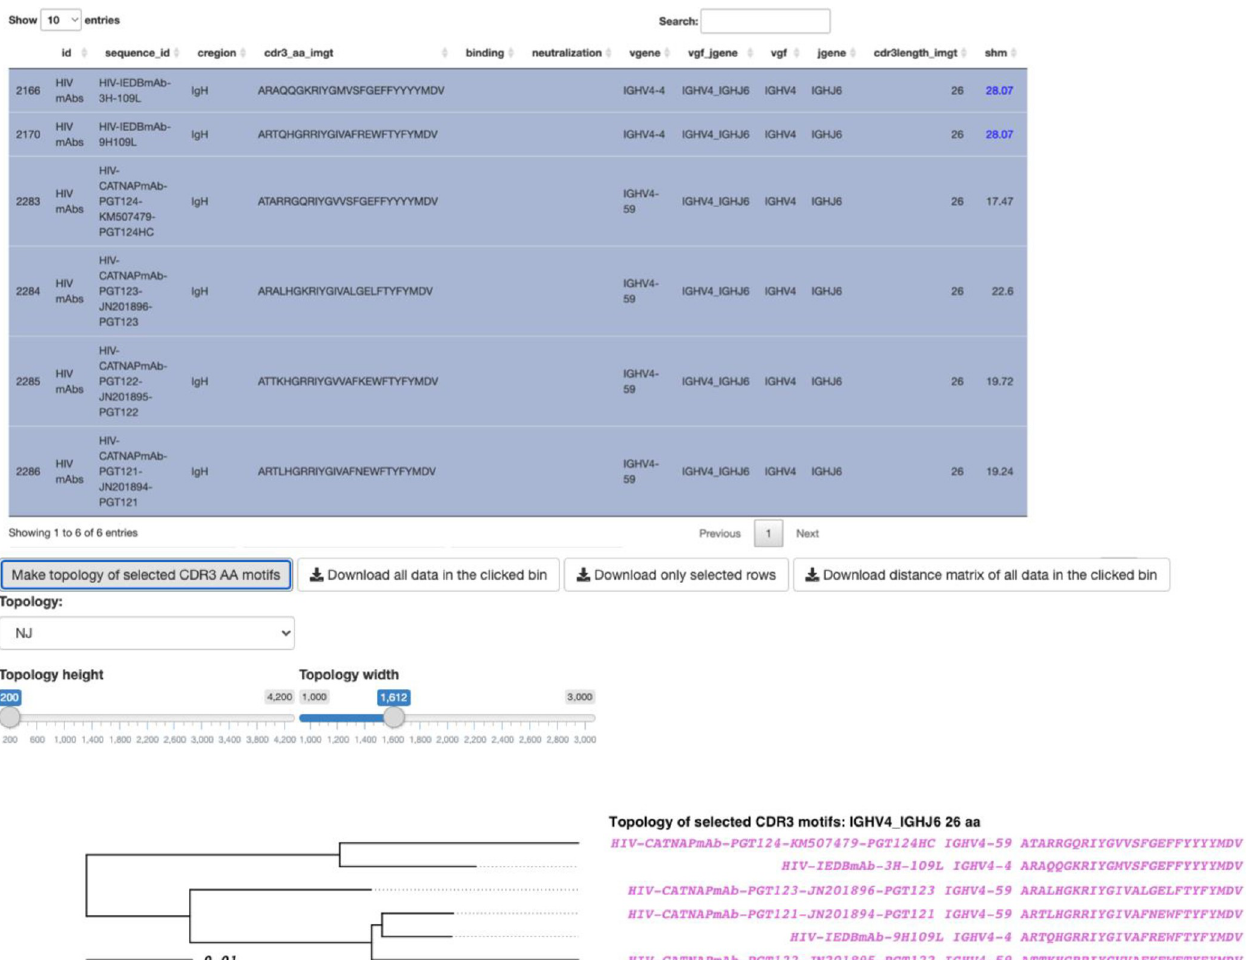
Fig 3. AIRRscape interface showing antibodies and CDR3 amino acid topology of selected antibody bin. Selected bin is highlighted in the red box of Fig 2B. SHM values in blue are calculated after an additional tblastn search of the NCBI nr/nt database.